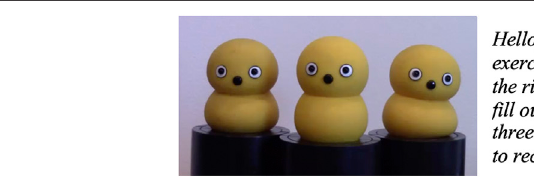
FIGURE 1 | The Keepon robots used and the text that the robot in the middle presented.